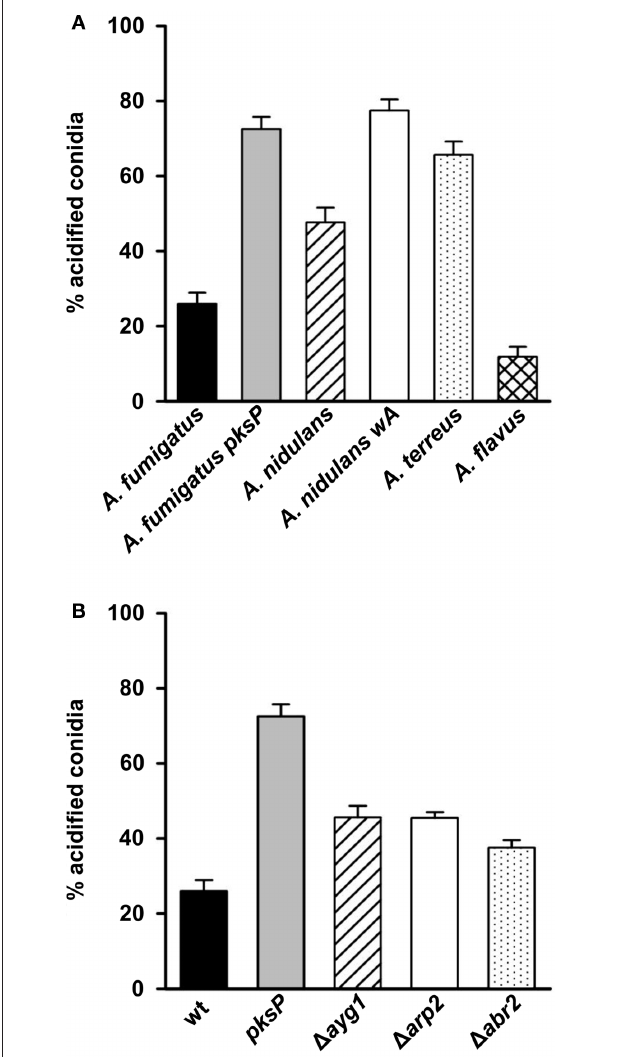
FiguRe 6 | impact on phagolysosome acidification of (A) different Aspergillus species and (B) A. fumigatus mutant strains accumulating different DHN-melanin precursor molecules. The percentage of intracellular conidia residing in acidified phagolysosomes after phagocytosis by MH-S cells was calculated. Values represent the mean + SD of